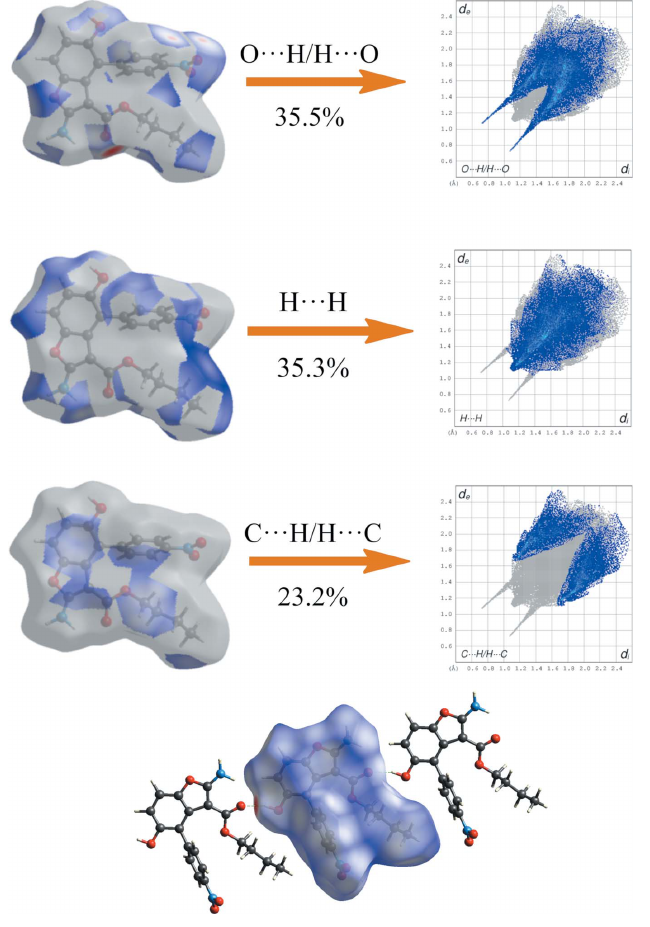
Figure 7 Two-dimensional fingerprint plots of significant intermolecular contacts for BF1 (major disorder component) with the d norm surfaces indicating the relevant surface patch associated with the specific contact. The Hirshfeld surface mapped over d norm with strong hydrogen bonded molecules outside is also shown.